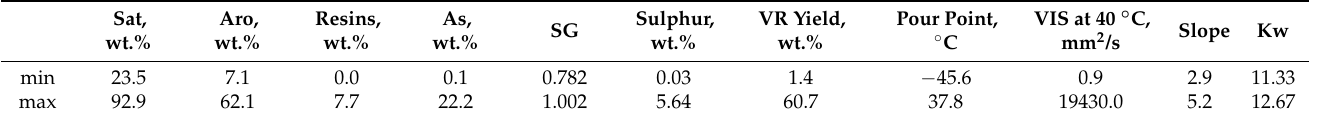
Table 4. Range of variations in the SARA composition and bulk properties of the studied crude oils. Sat, wt.%